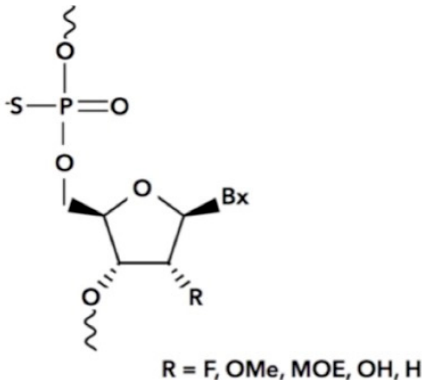
Figure 4. The phosphorothioate antisense oligonucleotide . The nonbridging oxygen of the phosphodiester is substituted with a sulfur atom to produce the phosphorothioate which is required for efficient Stabilin binding. Bx = purine/pyrimidine base, R = variable chemistries of both natural and unnatural modifications which includes fluoro (F), O-methyl (OMe), methoxyethyl (MOE), and hydroxyl (OH).